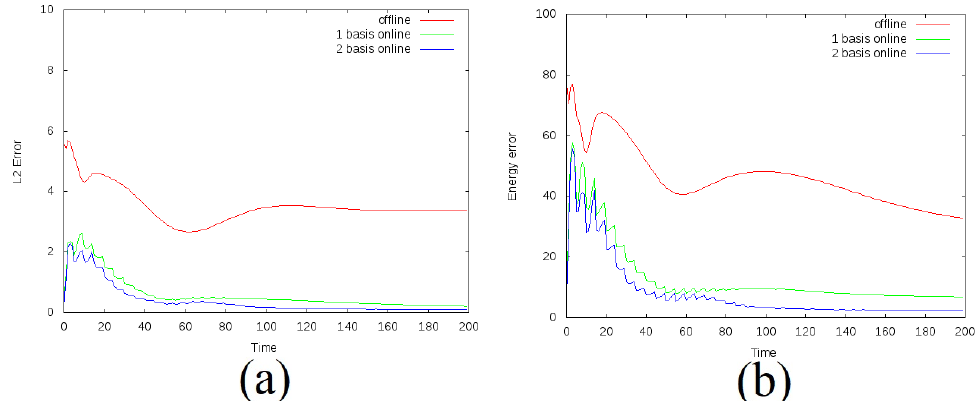
Figure 8. Numerical results for Test 2 . Error comparison between offline approach using 3 offline basis and online approach using 1 and 2 online basis. ( a ): L 2 error. ( b ): energy error.